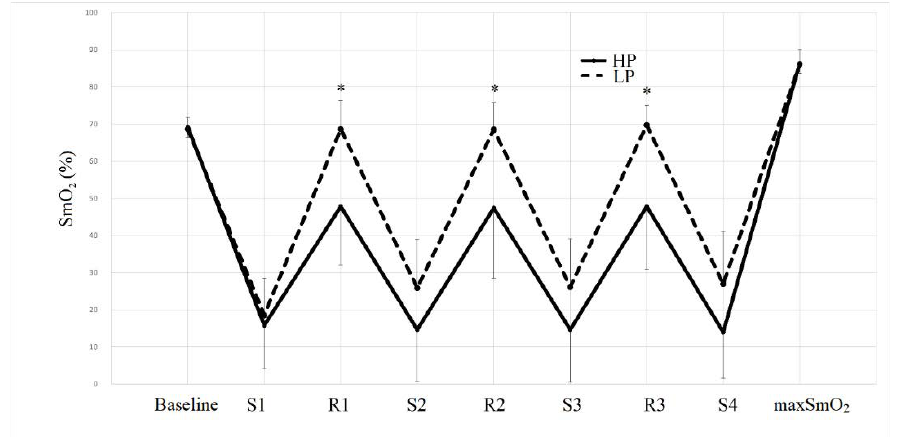
Figure 2. Muscle oxygen saturation (SmO 2 ) at baseline, at the end of the first set (S1), at the end of the first inter-set recovery time (R1), at the end of the second set (S2), at the end of the second inter-set recovery time (R2), at the end of the third set (S3), at the end of the third inter-set recovery time (R3), at the end of the fourth set (S4) and within 3 min following the last repetition of the last set (maxSmO 2 ). * indicates a significant ( p ≤ 0.05) difference between HP and LP. HP = high pressure; LP = low pressure.